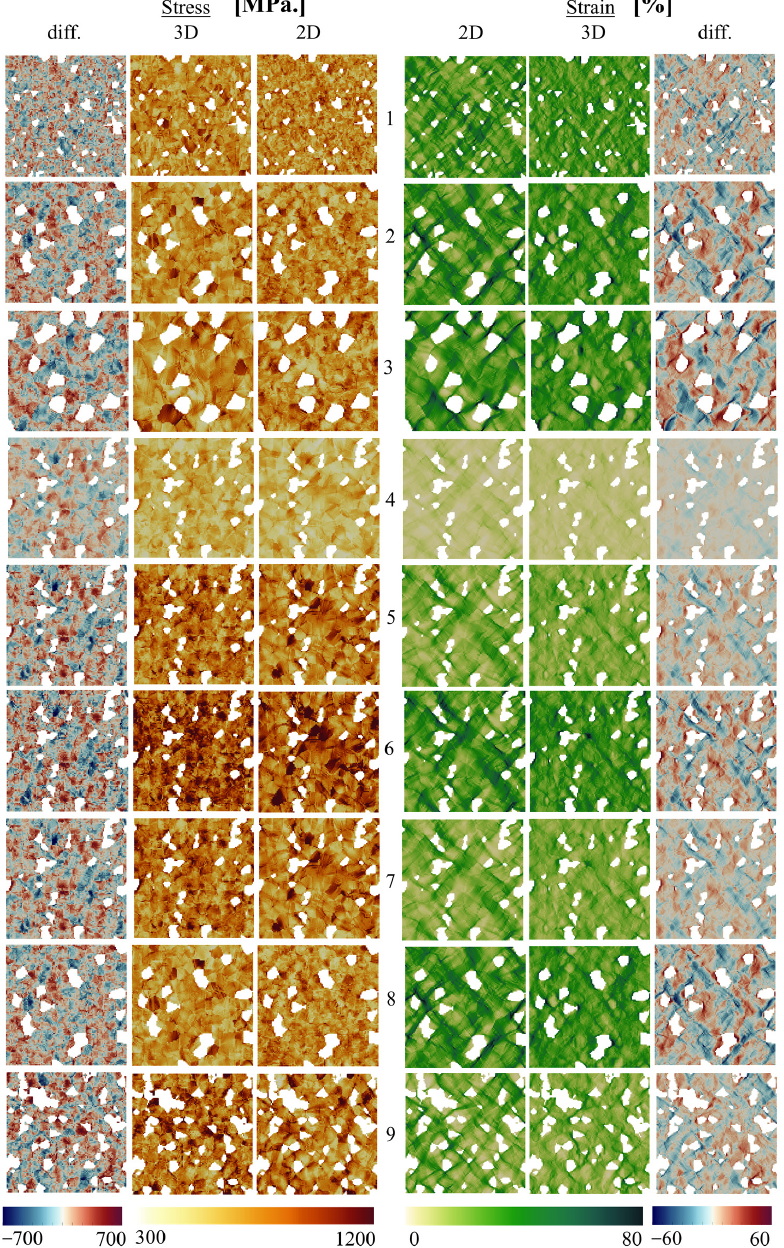
Figure 3. Local von Mises stress and strain distribution for ferrite phase from case 1 to case 9. Note that case 1 to case 3 indicate different total grain numbers; case 4 to case 6 indicate different strain levels; case 7 to case 9 indicate different volume fractions. The extreme left and right column indi- cates the 2D and 3D local stress and strain distribution differences, respectively.